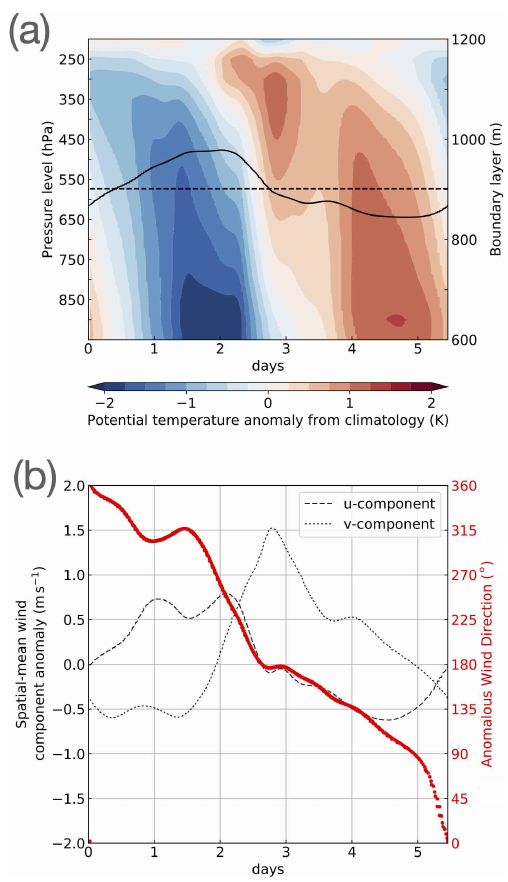
Figure 10. Phase tendency analysis along the closed trajectory shown in Fig. 9 for (a) area-averaged potential temperature profile (colour shading, difference from winter climatology) and boundary layer height (dashed line, with winter climatological mean indicated by solid line); (b) meridional (dotted), zonal (dashed) anomalous wind components and corresponding anomalous wind direction (red dots) at the 950hPa level. The horizontal coordinate axis indicates the time progression in days along the closed